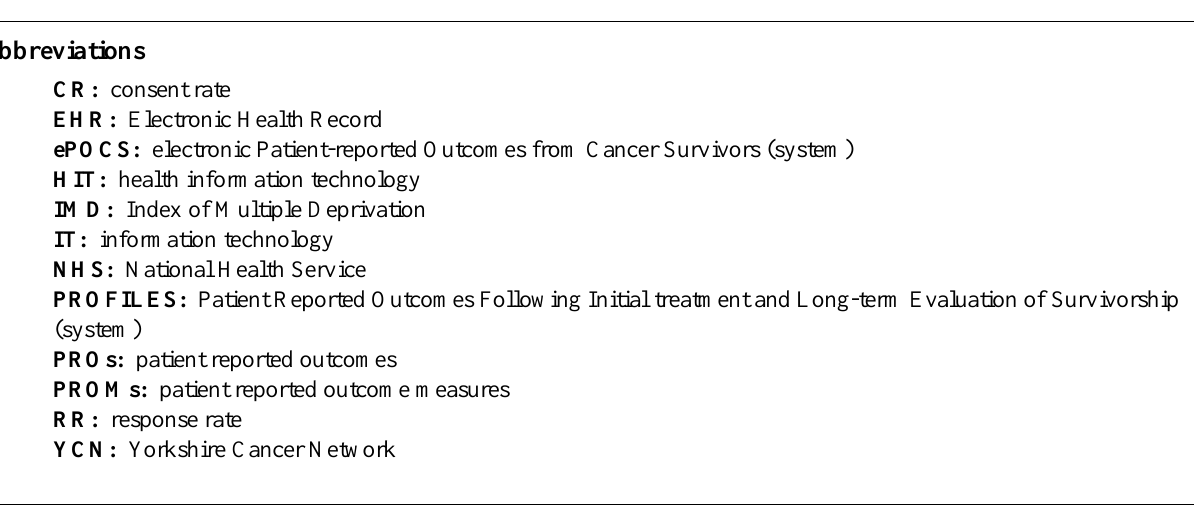
YCN: Yorkshire Cancer